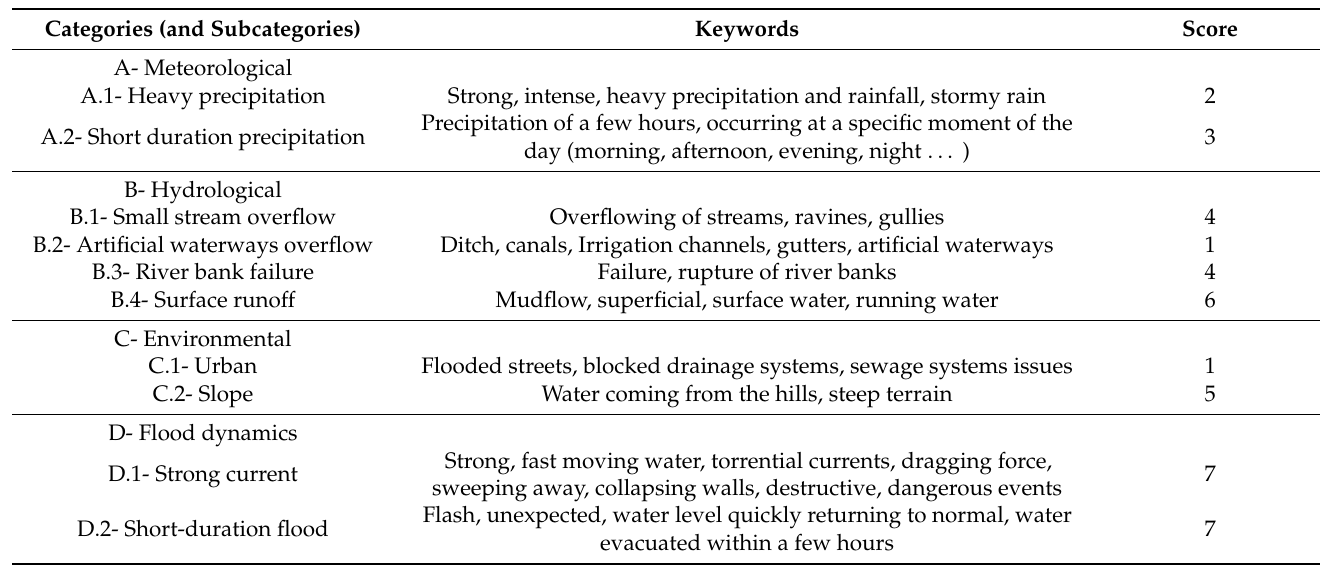
Table 1. Categories and subcategories of flash flood drivers. Flash flood keywords and score indicating a subcategory relative contribution to flash flood